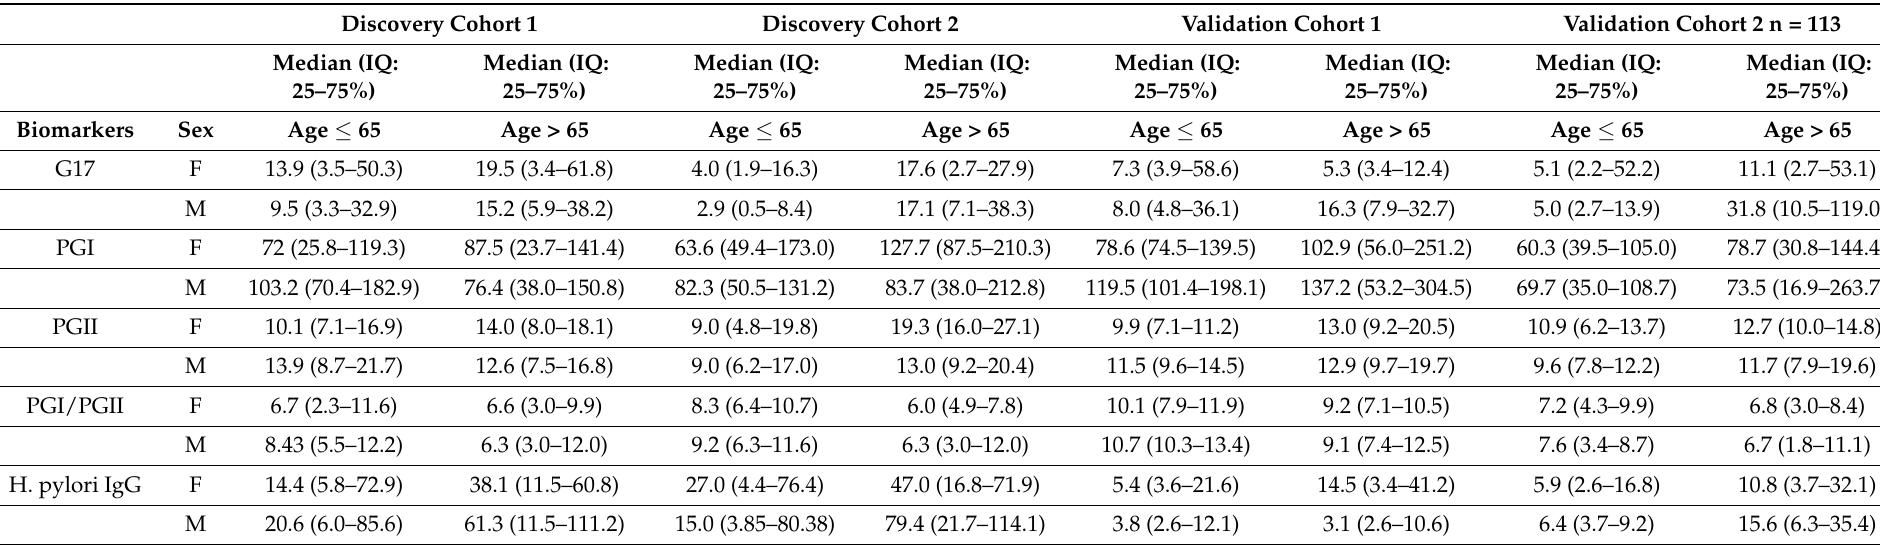
Table 1. Distribution of demographic and serological data in the discovery and validation cohorts according to sex and age categories. Discovery Cohort